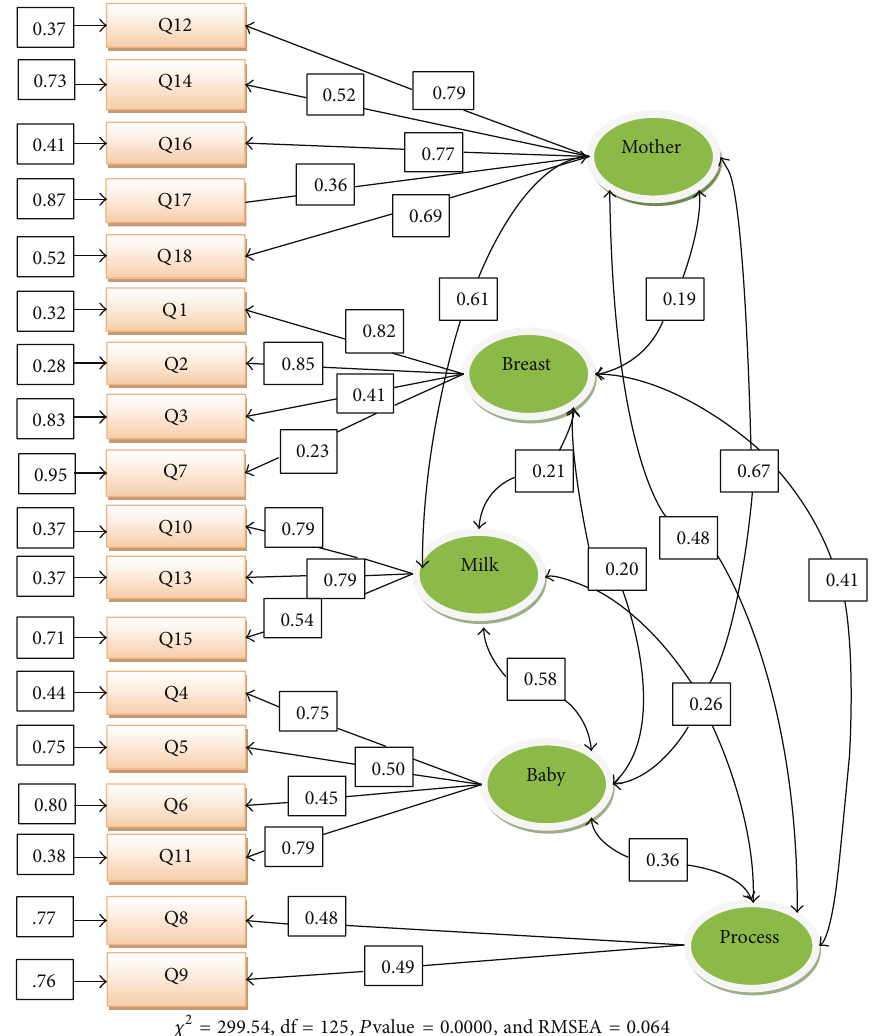
Figure 1: CFA of the new five-factor model of the BES (the item numbers refer to question numbers in the original questionnaire).